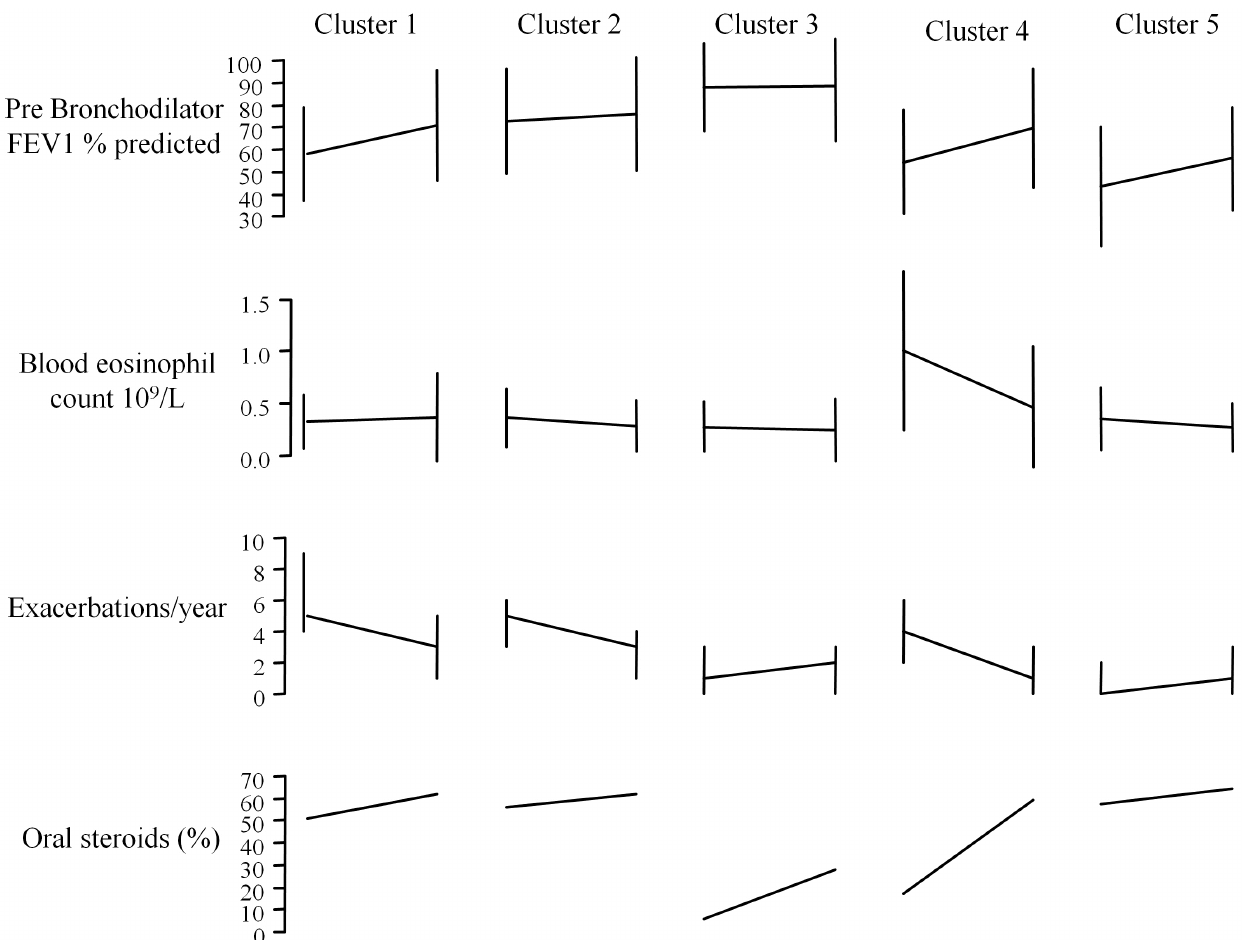
Figure 1. Differences in clinical outcomes between baseline and follow-up for each cluster. Pre Bronchodilator FEV1 % predicted and Blood eosinophil count statistics are Mean ( + / 2 SD). Exacerbation frequency outcomes are median (IQR) and percentage on oral steroids are percentages.